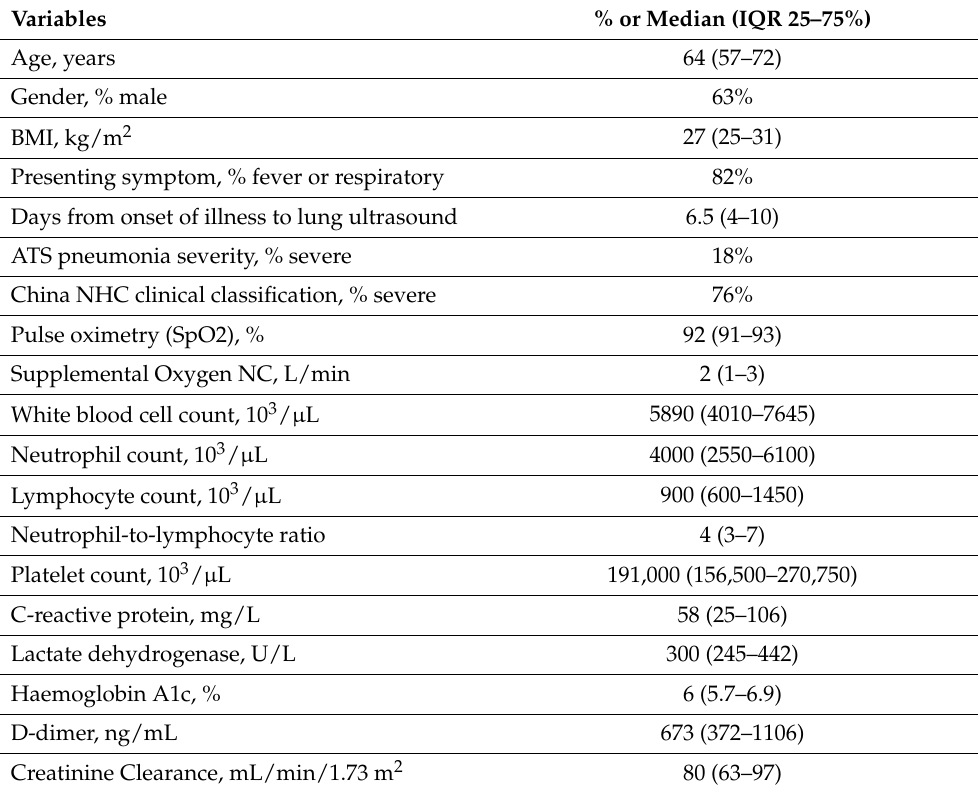
Table 1. Baseline demographics, clinical and laboratory